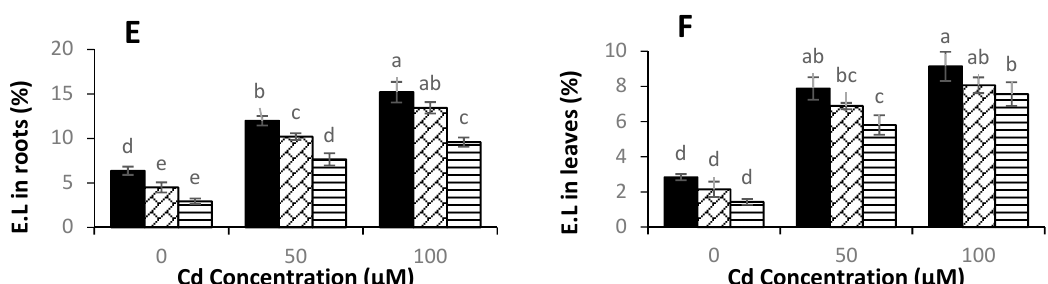
Figure 4. The influence of the foliar application of peptone (0, 500, and 1000 mgL − 1 ) on MDA in roots ( A ), MDA in leaves ( B ), H 2 O 2 in roots ( C ), H 2 O 2 in leaves ( D ), EL in roots ( E ), and EL in leaves ( F ) of spinach plants grown under Cd stress. Values represent the means of four replicates with standard deviations. Letters on the bar indicate the significant differences between given treatments at p < 0.05.